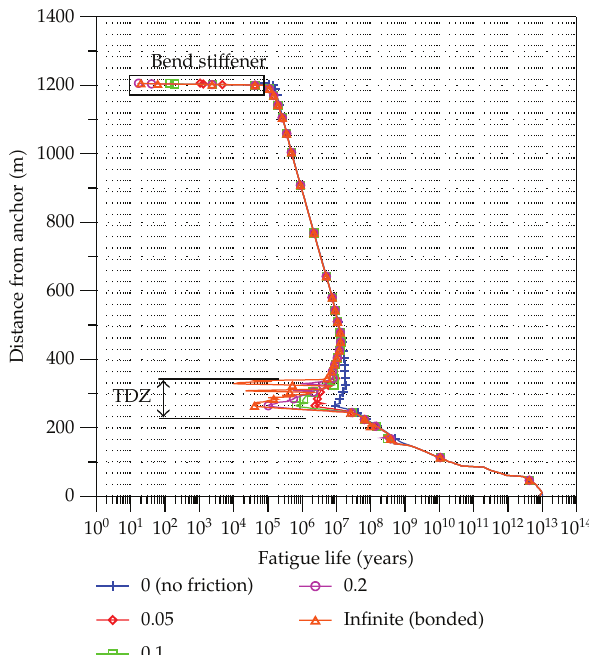
Figure 11: Fatigue life in the inner armor along the flexible pipe: e ff ect of di ff erent coe ffi cients of friction.